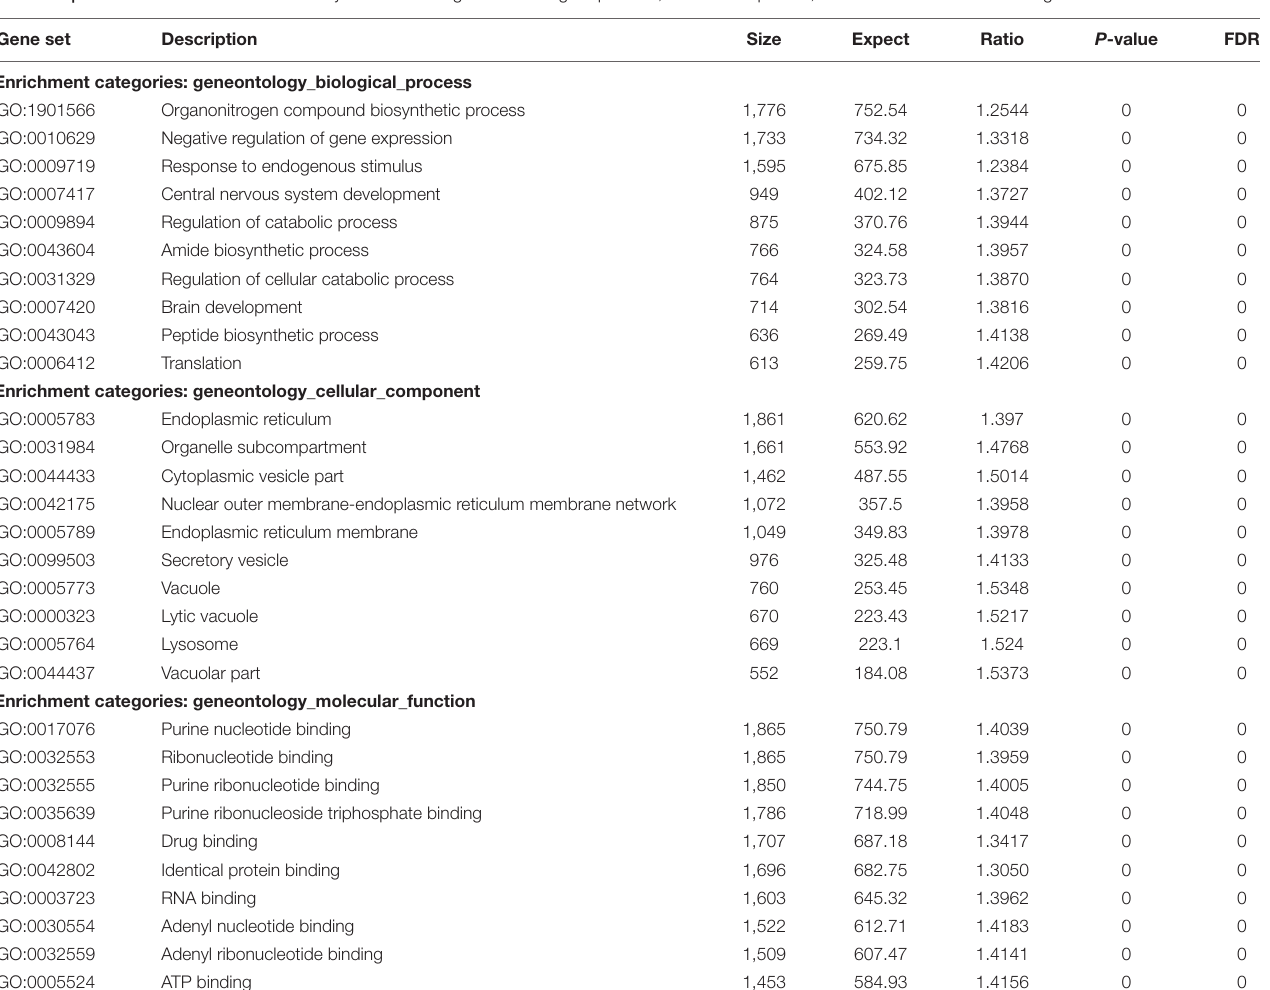
TABLE 3 | The results of the enrichment analysis for the categories of biological process, cellular component, and molecular function ontologies. Gene